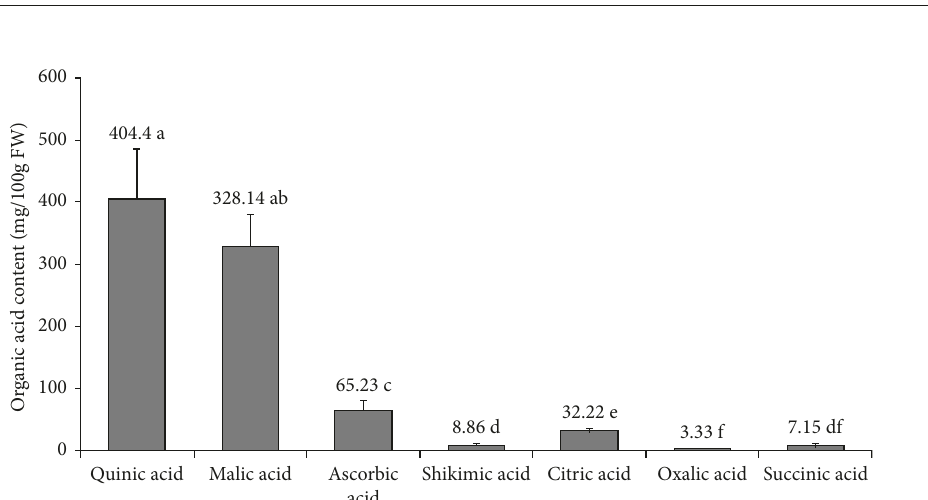
Figure 2: Average content (mg/100 g FW) of organic acids in 23 samples of black chokeberry fruits. Results are presented as mean values from all samples ± SD. There are no significant differences among values marked with the same letters in individual